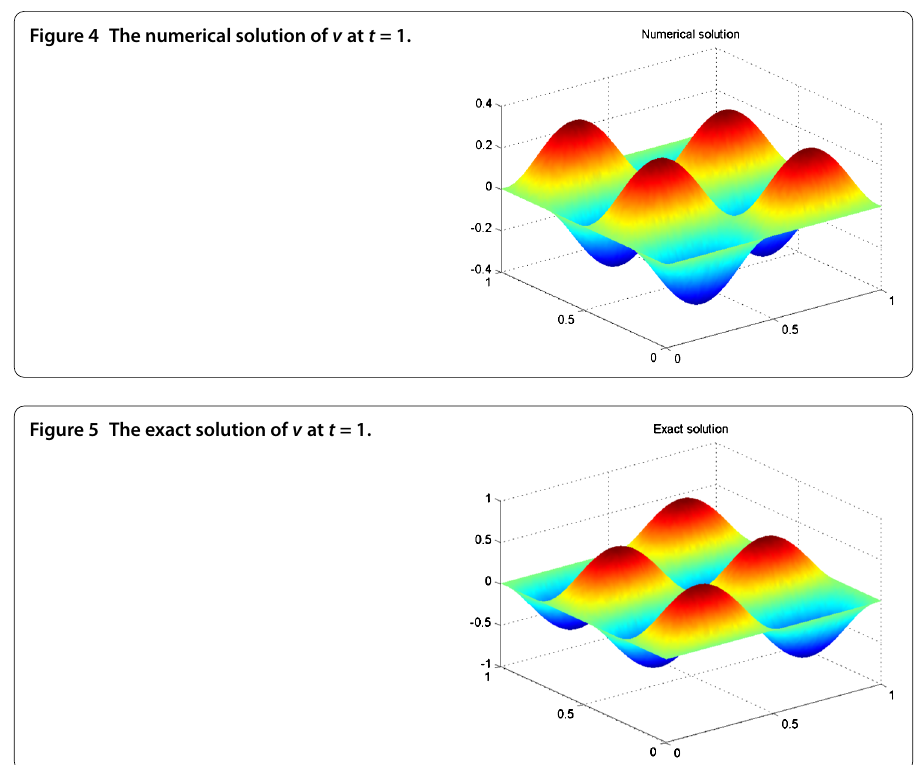
Figure 4 The numerical solution of v at t = 1.